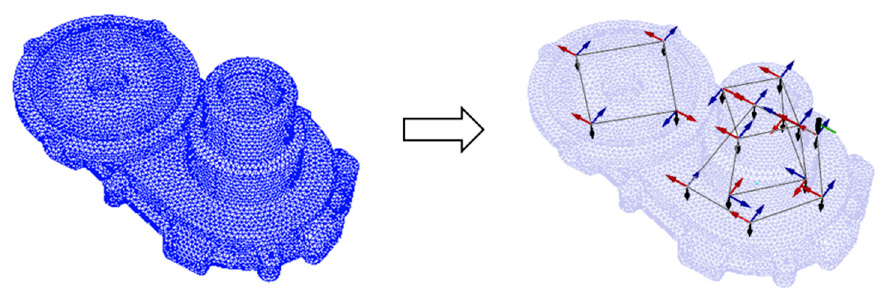
Figure 2. Test geometry modeling by FE model decimation.